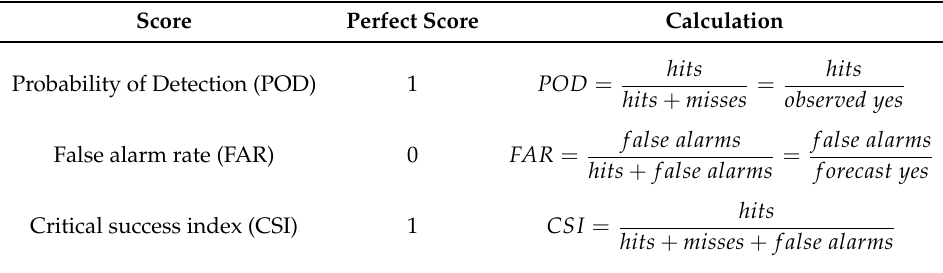
Table 3. Multicategory scores.